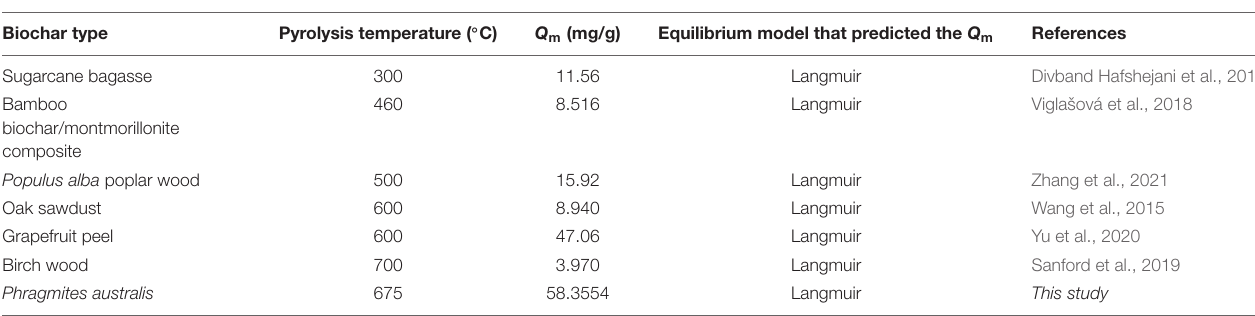
FIGURE 9 | The C1s XPS spectrum of PBC before (A) and after (C) adsorption and TPBC before (B) and after (D) adsorption. TABLE 6 | Data of TC removal using biochars reported in various